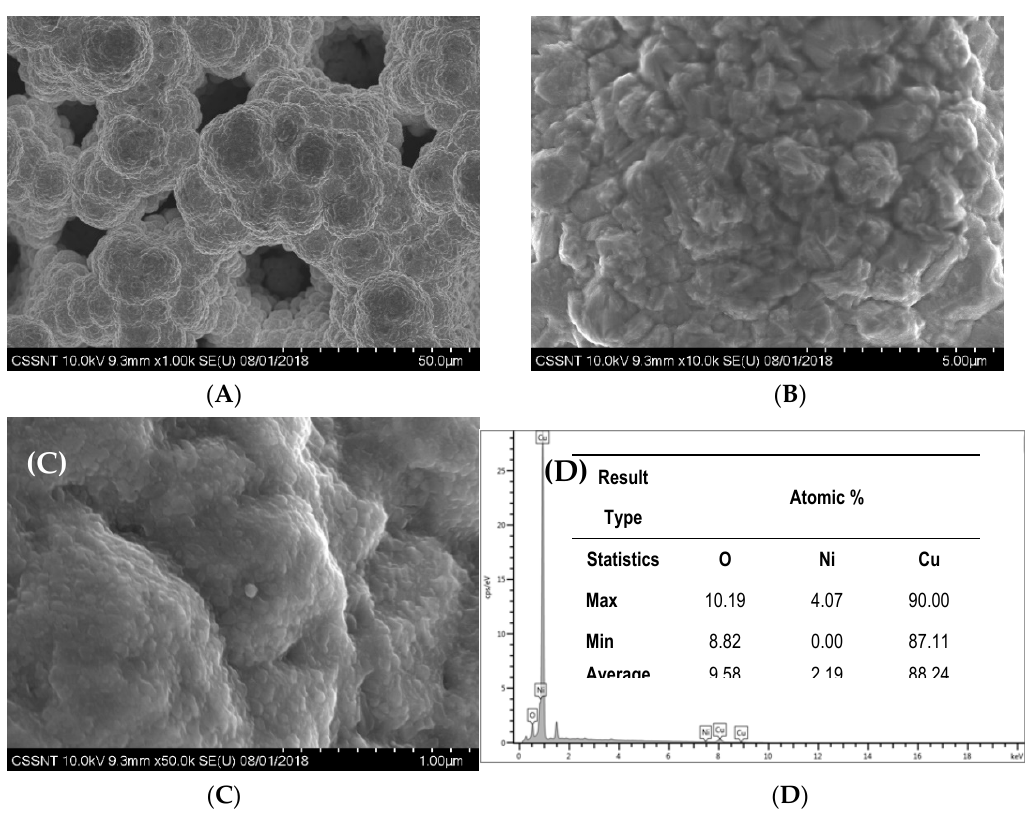
Figure 2. SEM micrographs at different magnifications ( A : x 1000; B : x 10,000; C : x 50,000) and corresponding EDX analysis ( D ) of Cu electrodeposited onto Ni foam at 35 mA/cm 2 for 15 min.